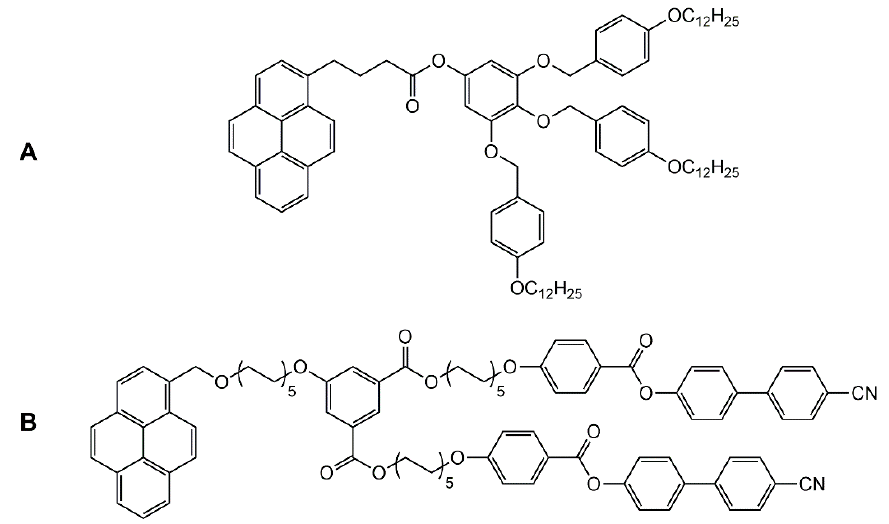
Figure 9. Two pyrenyl-functionalized liquid-crystalline compounds ( A , B ) showing suppressed liquid-crystalline properties after encapsulation in a coordination complex [46,47].